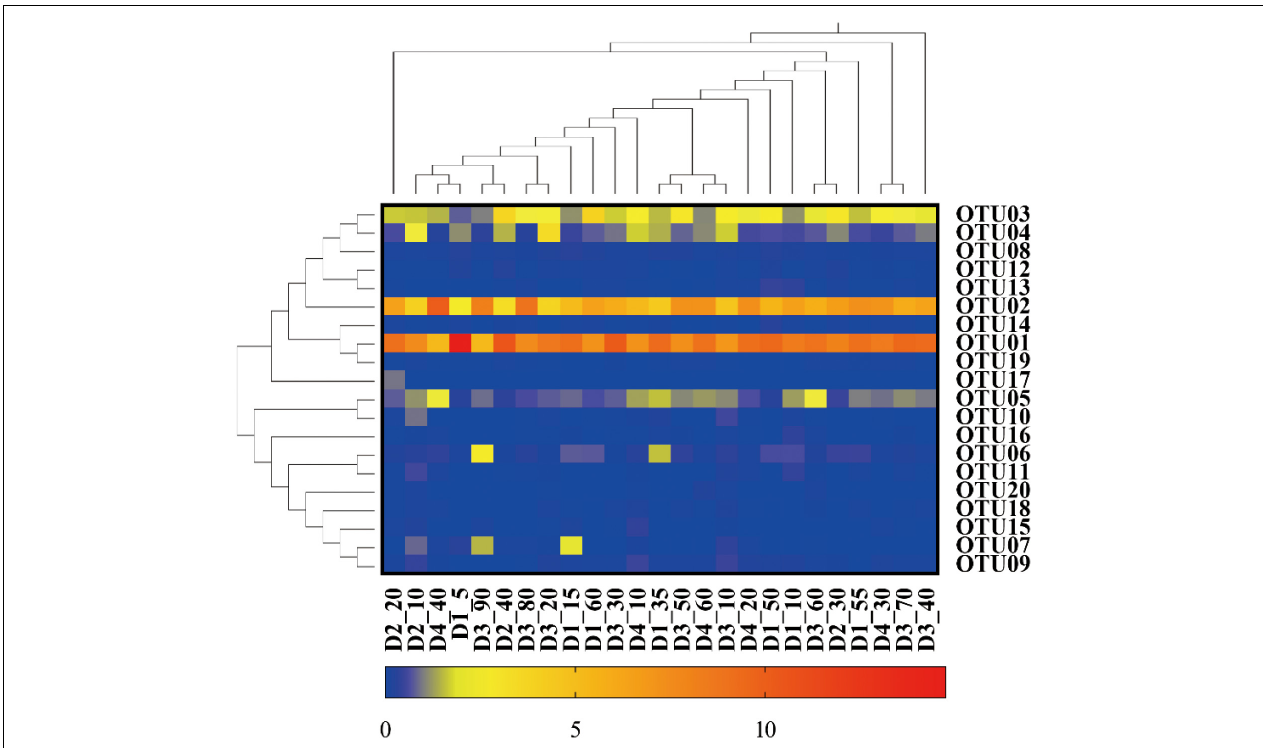
FIGURE 3 | Heat map of Nitrospira in sediment of the DYB (STE). Dl, D2, D3, and D4 stands for sediment cores with a depth of 110, 90, 90, and 80 cm, respectively. As shown in core Dl, every 5 cm sediment section was mixed as one sample named from D15 to Dl_90, while sample Dl_100 and sample Dl_110 represent sediment sections from 90 to 100 cm and from 100 to 110 cm, respectively. For core D2, Core D3 and core D4, every 10 cm sediment section was mixed as one sample with the same naming policy. The 20 dominant OTUs in sediments of the DYB (STE) (OTUs of sequence number > 0.1%) were clustered, which accounted for 97.63% of the total sequence